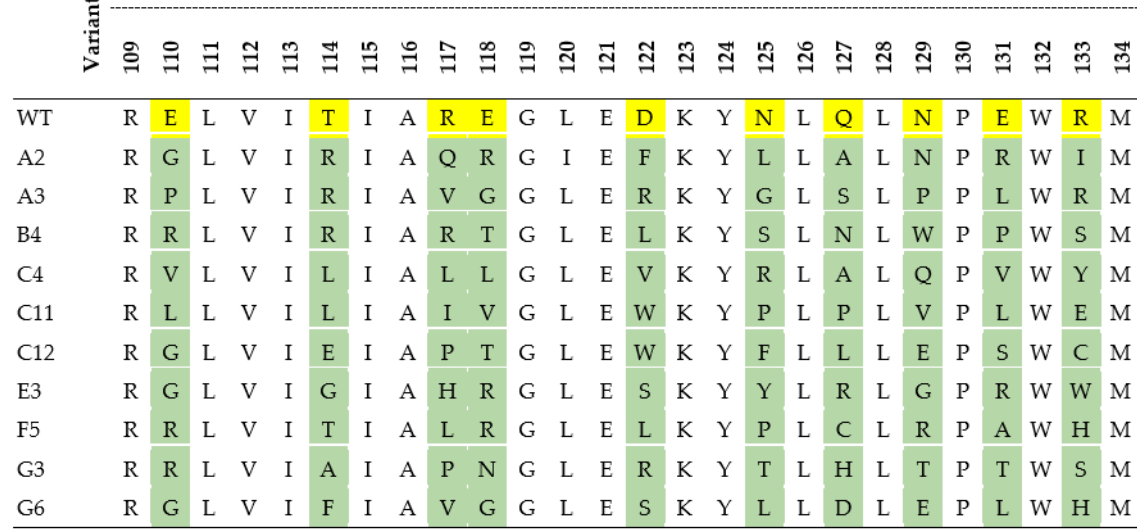
Figure 5. The amino acid sequence of the wild type ProBi-WT protein scaffold. The N-terminal Strep-tag and C-terminal c-Myc-tag are in bold, the 4PSF scaffold segment is in italic. The ten mutable amino acid residues forming the PatchC are highlighted in red.